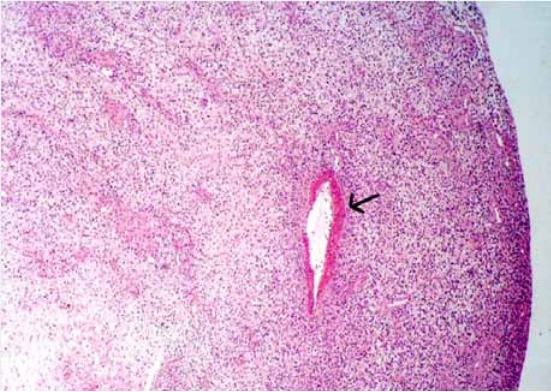
Figure 1. Histopathological exam (HE stain, ob.10x); the electron microscopic appearence of the embryonal type of rhabdo-